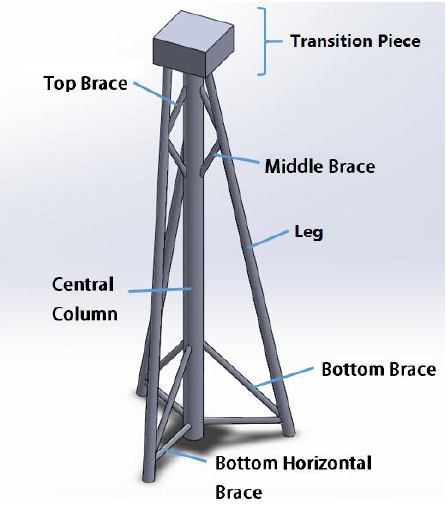
Figure A3. Terminology of the structural members of a TJ-structure.